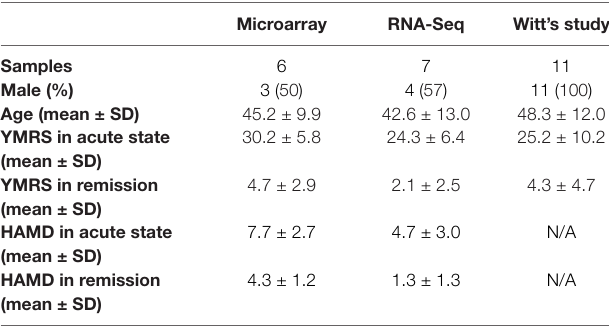
TABLE 1 | Demographic data of all subjects in different platforms of the present